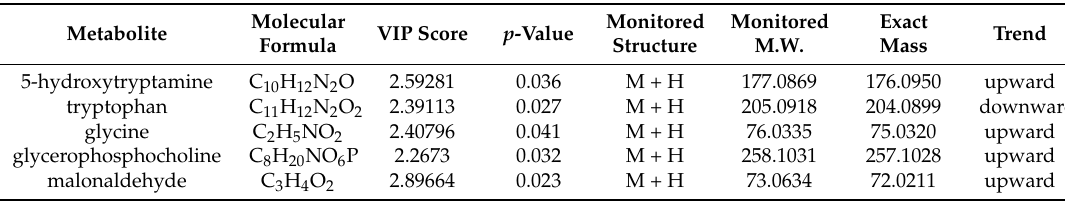
Table 1. LC-MS/MS data of the discriminant metabolites related to NP exposure and their identification